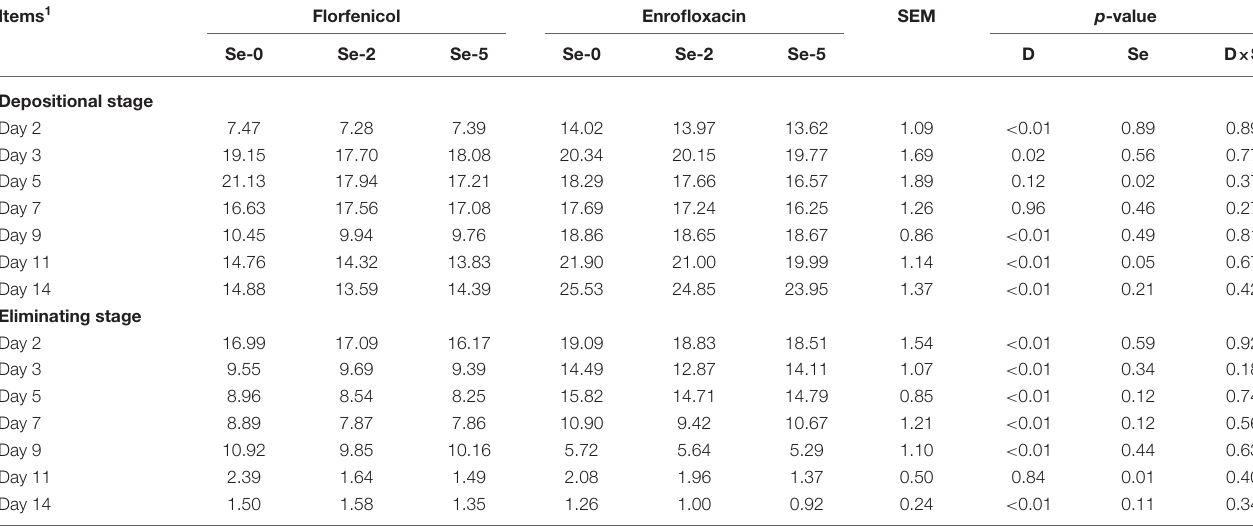
TABLE 4 | Effects of dietary organic selenium on residue of drugs in plasma of laying hens. Items 1